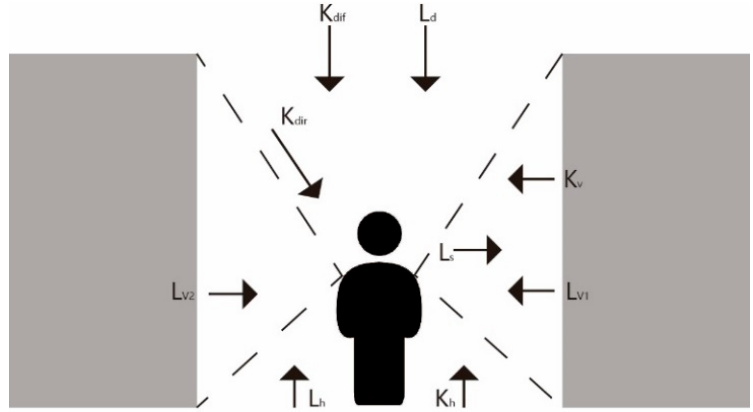
Figure 1. Outdoor energy exchange between block and surrounding urban environments.